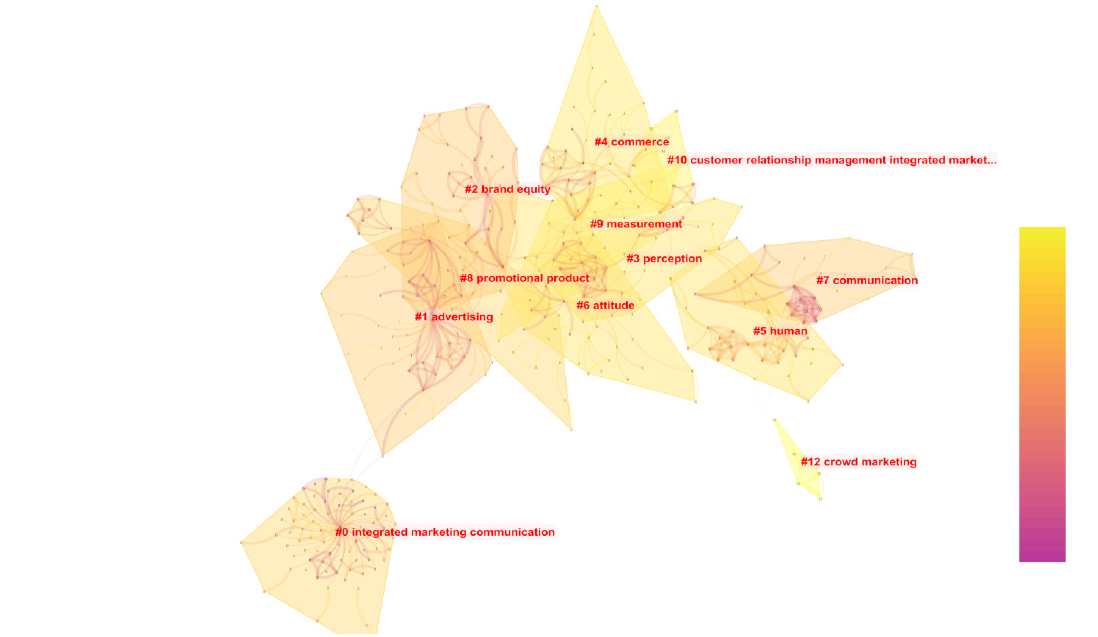
Figure 7. Keyword co-occurrence map in IMC